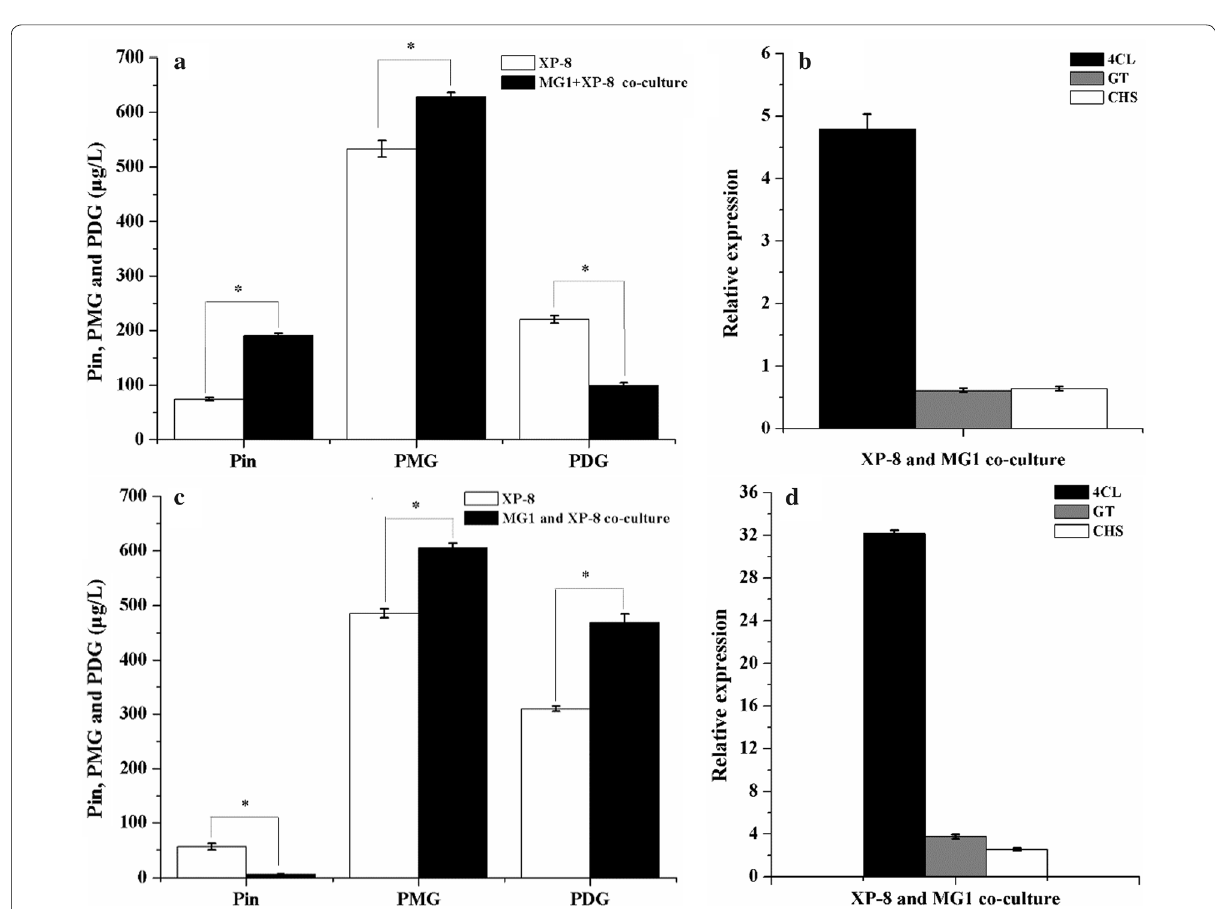
Fig. 3 Target product yield and gene expression in the co-culture method with Alternaria sp. MG1 spores using PDB medium ( a , b ) and the obtained resting cells ( c , d